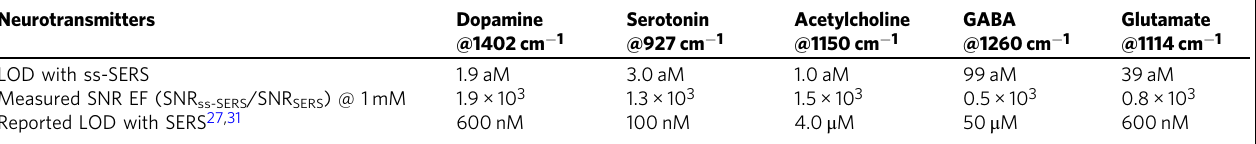
Table 1 LOD and SNR enhancement of ss-SERS.